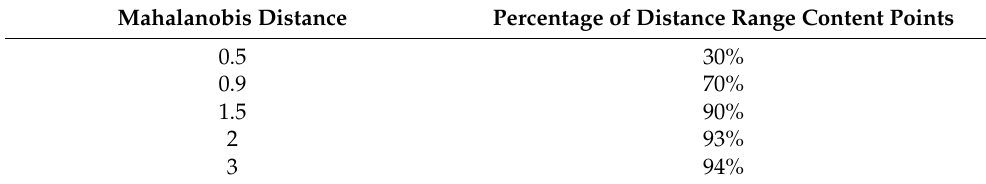
Table 8. Table of relationship between distance and